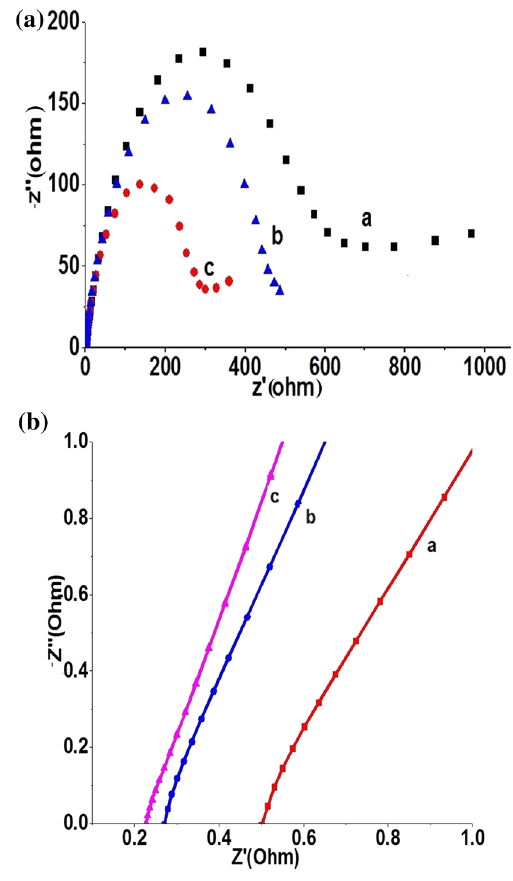
Fig. 8 Nyquist plot of a PVdF, b PVdF–PMMA (80:20) and c PVdF– PMMA (50:50) nanofibrous polymer electrolyte membranes